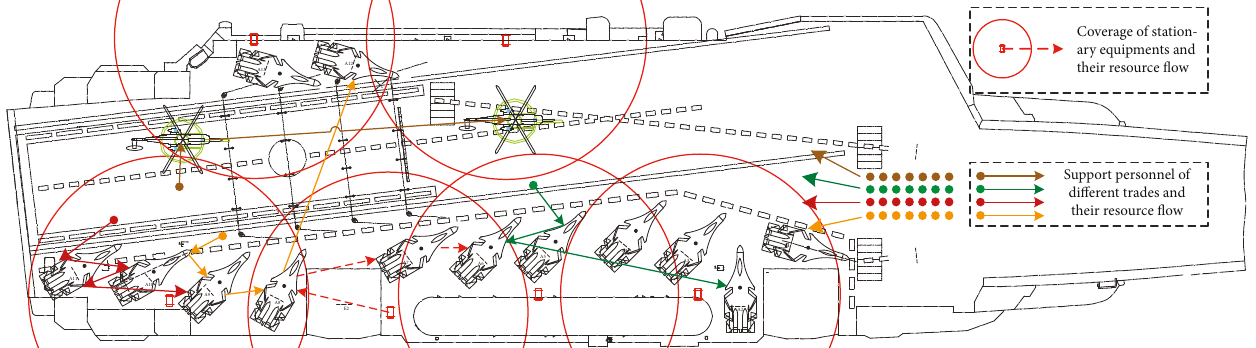
Figure 3: Resource fl ow on fl ight deck of the Admiral Kuznetsov aircraft